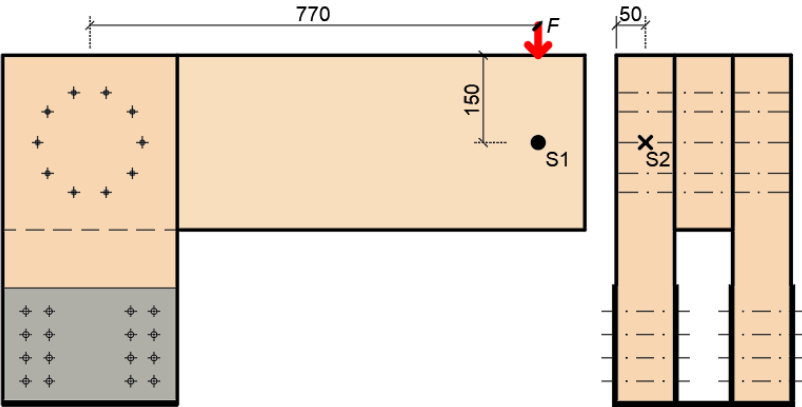
Figure 4. Position of strain gauge sensors: front view (on the left), side view (on the right).